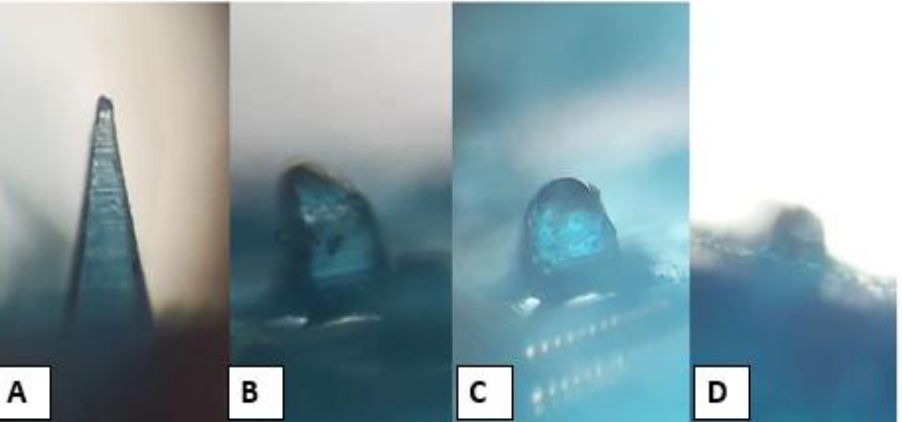
Figure 8. Morphological changes in the MN-3 after insertion into the rat skin at ( A ) 0, ( B ) 5, ( C ) 10, and ( D ) 20 min.